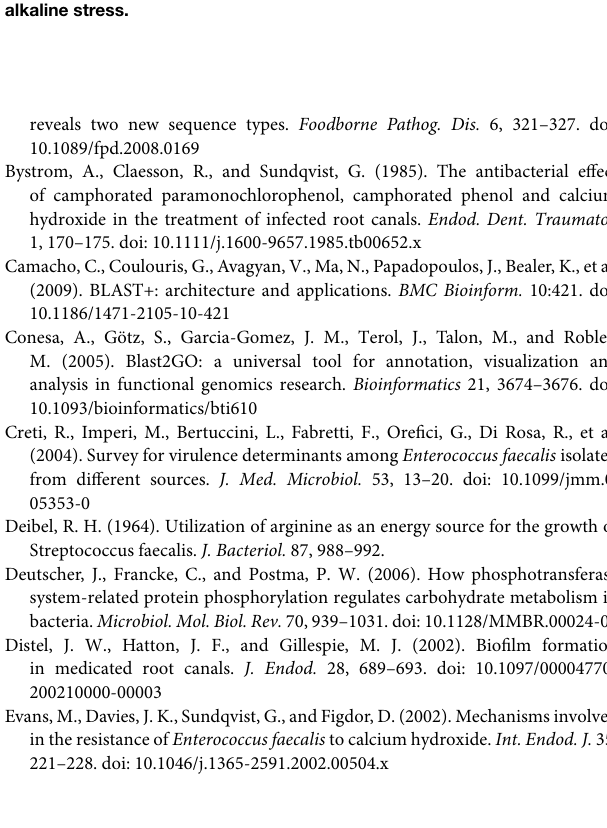
Table S1 | KEGG summary of E. faecalis sequences (XLS). Table S2 | The detail sequence information of the transcriptome. Table S3 | The data of all of the gene transcription information (XLS). Table S4 | The list of genes found to be induced (up-regulated) in alkaline stress. Table S5 | The list of genes found to be decreased (down-regulated) in alkaline